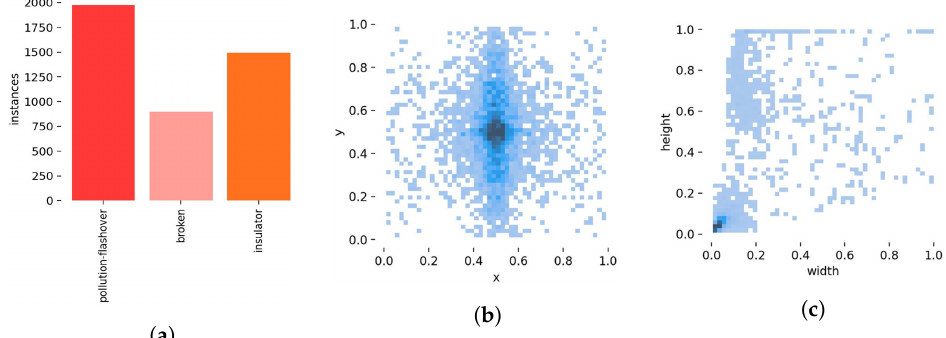
Figure 3. Labels and label distribution: ( a ) number of labels; ( b ) label location; ( c ) label size.